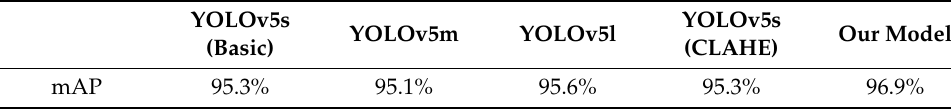
Table 9. Analysis of mAP between YOLOv5 models.